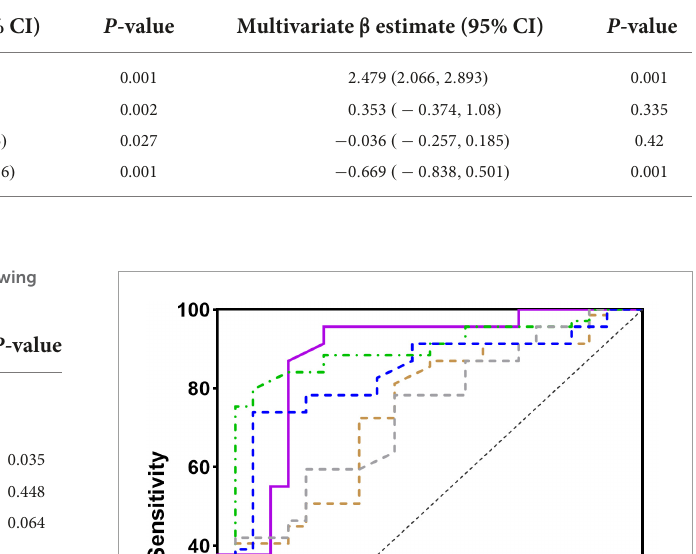
TABLE 3 Results of univariate and multivariate linear regression analysis of mechanical parameters and LGE.